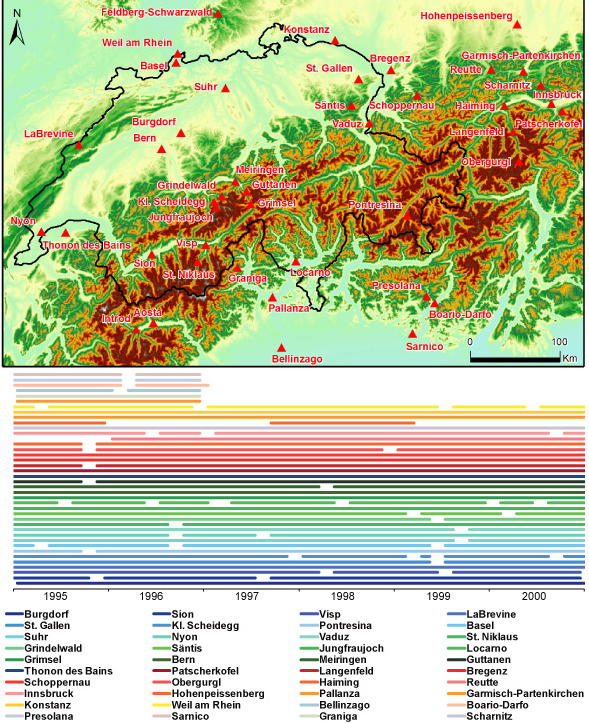
Fig. 1. Spatial distribution of the 43 stations with available records of monthly stable oxygen isotope ratio of precipitation over Switzerland and its border region. Temporal distribution is shown between 1995 and 2000. (Data sources: NISOT (Schürch et al., 2003), ANIP (Kralik et al., 2003), GNIP (IAEA, 2010), N-Italy (Longinelli and Selmo, 2006, 2003) and the network run by the Division of Climate and Environmental Physics, Physics Institute, University of